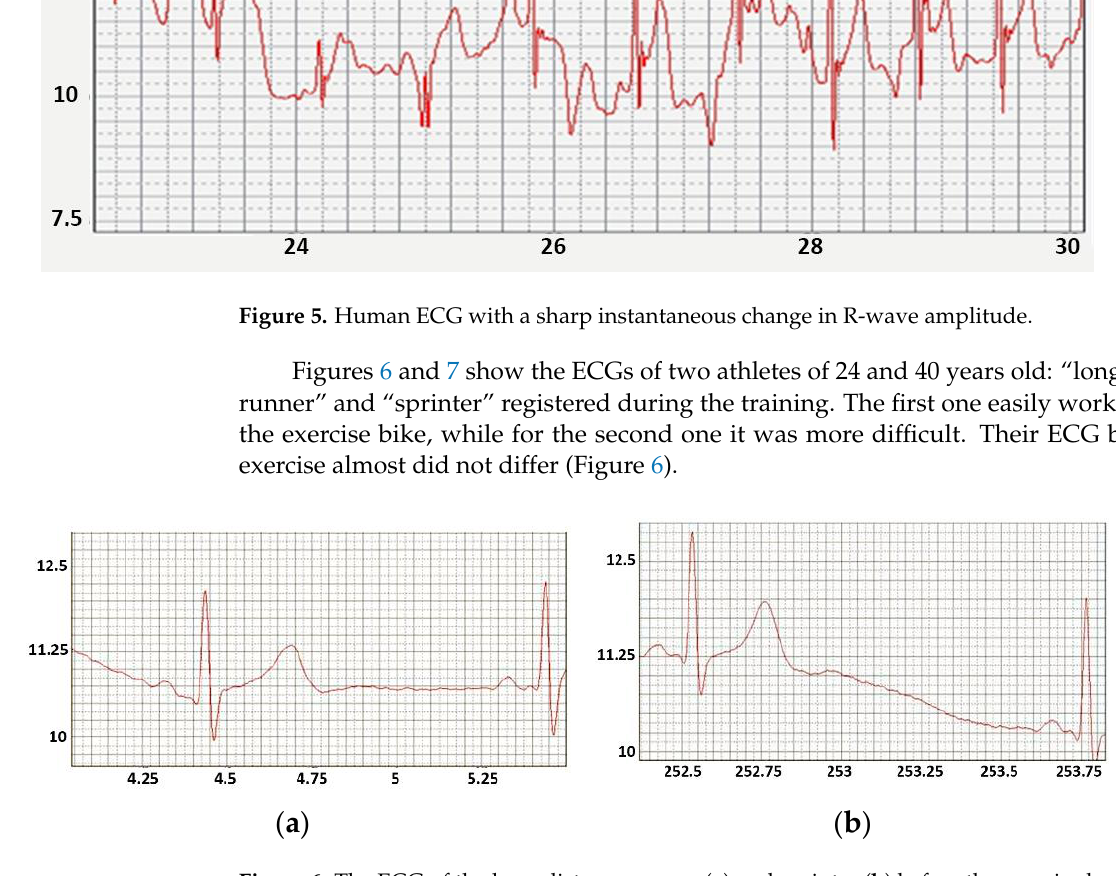
Figure 6. The ECG of the long-distance runner ( a ) and sprinter ( b ) before the exercise load.